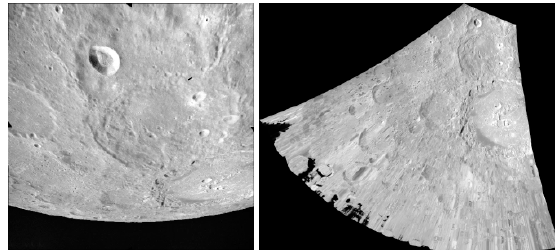
Figure 4: AS15-M-2515 (NASA/JSC/ASU) from 40°S oblique orbit 71. Left: raw image with limb. Right: projected image shows artifacts that may occur when projecting highly oblique data toward the limb.